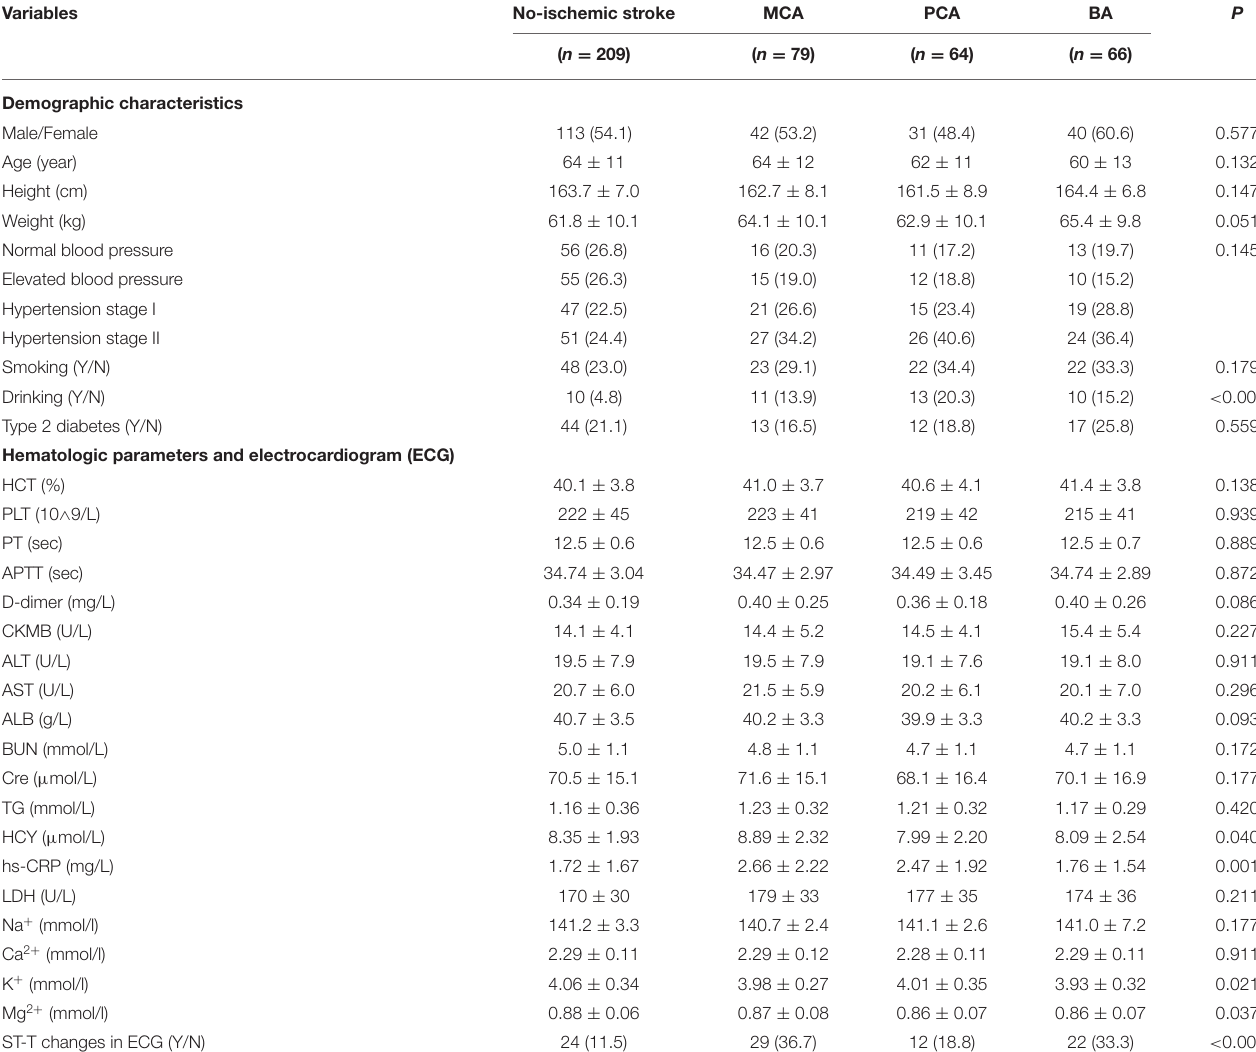
TABLE 1 | The demographic characteristics, hematologic parameters and electrocardiogram between the ischemic stroke group (MCA, PCA, BA) and the no-ischemic stroke group.